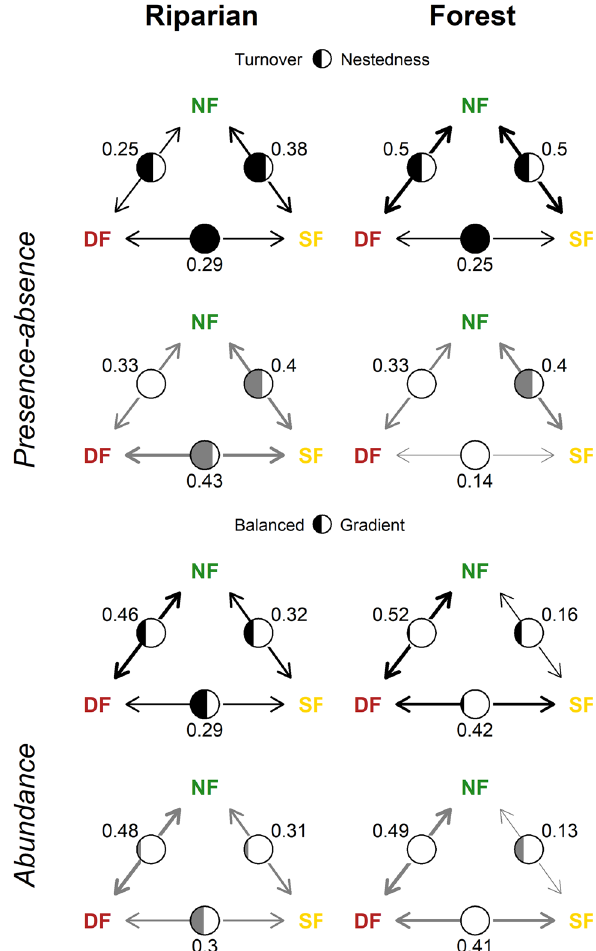
Figure 4. Beta diversity of understory bats between natural forest (NF), semi-natural forest (SF), and degraded forest (DF) in riparian and forest habitat based on presence-absence and abundance data for all species (black circles) and phyllostomid species (gray circles). Incidence-based beta diversity was partitioned into species turnover and nestedness 46 . Abundance-based beta diversity was partitioned into balanced variation in species abundances and abundance gradients 47